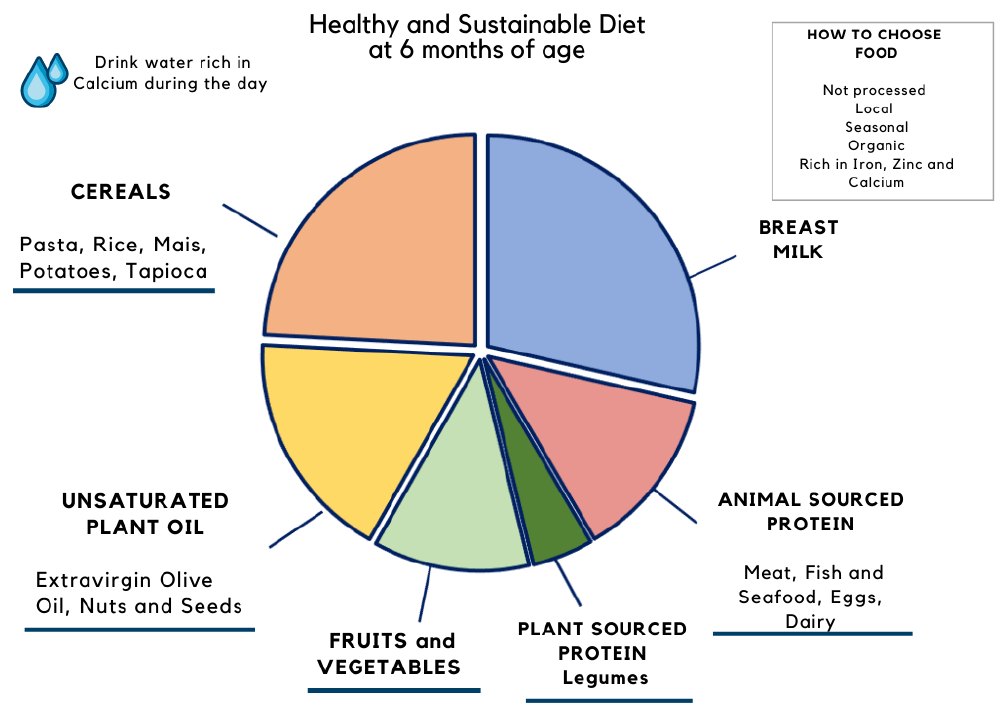
Figure 2. Proposal of a sustainable diet that respects EFSA nutritional recommendations for an infant of 6 months of age fed breast milk on demand and 2 complementary feeding meals. In the first year, breast milk supply should preferably provide an energy intake of between 33% and 50% of total energy.